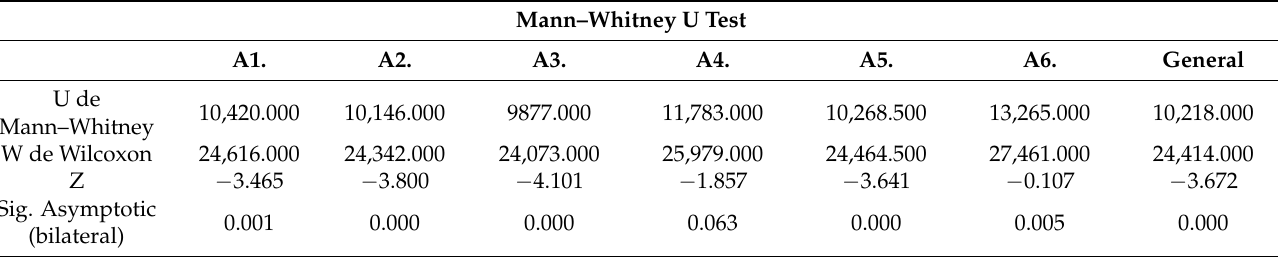
Table 4. Mann–Whitney U test with non-COVID-19 grouping variables